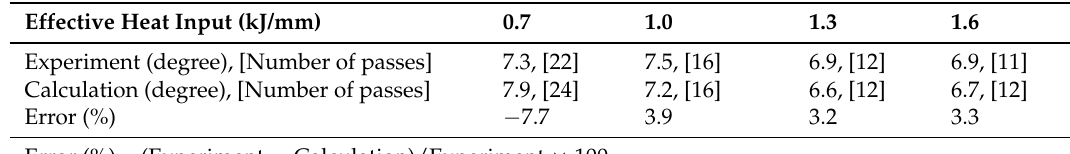
Table 4. Final angles by experiment and calculation.